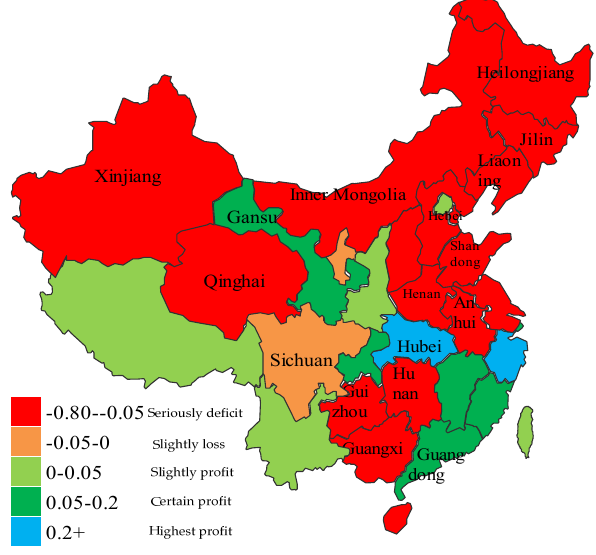
Figure 3. National profitability map.